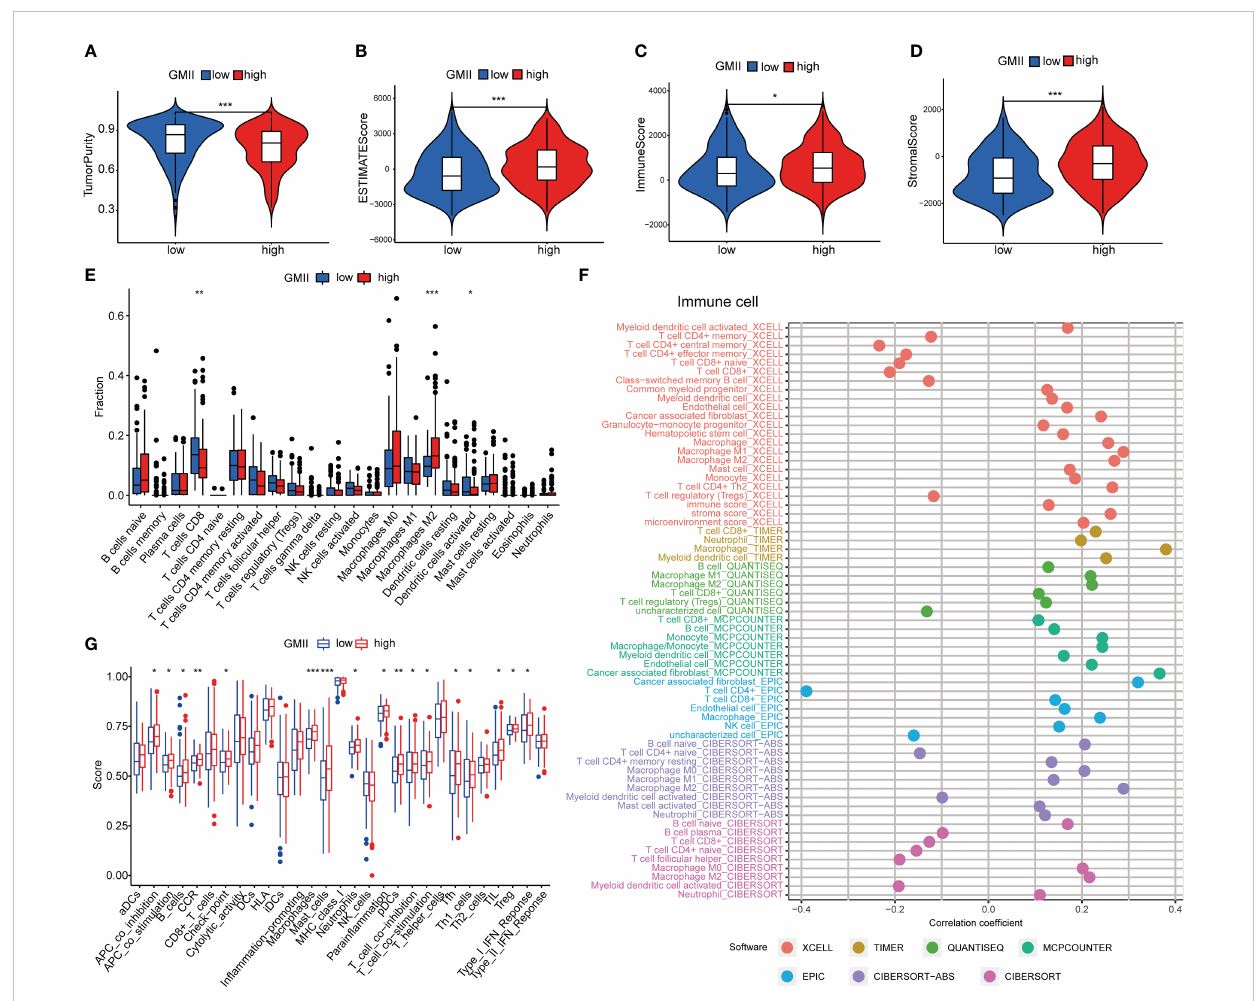
FIGURE 5 Immune cell in fi ltration in high-GMII and low-GMII groups. Tumor purity (A) , ESTIMATE score (B) , immune score (C) , and stromal score (D) between high – and low-GMII populations. (E) CIBERSORT algorithm was used to analyze the contents of immune cell in fi ltration in high-GMII and low-GMII groups. (F) Different software evaluated the correlation between immune scores and immune cells. (G) ssGSEA algorithm showed immune cell in fi ltration of immune-related functions and pathways in high-GMII and low-GMII groups. * p < 0.05 、 ** p < 0.01, *** p <